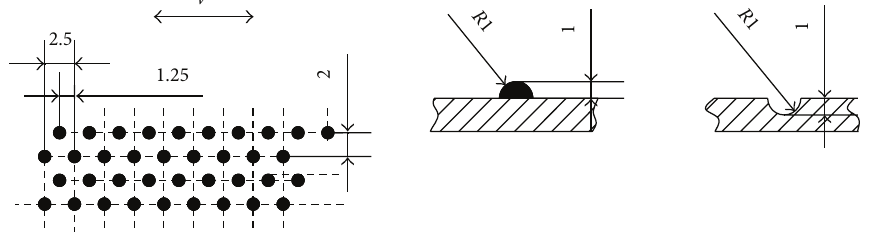
Figure 7: Size of the nonsmooth surface units.